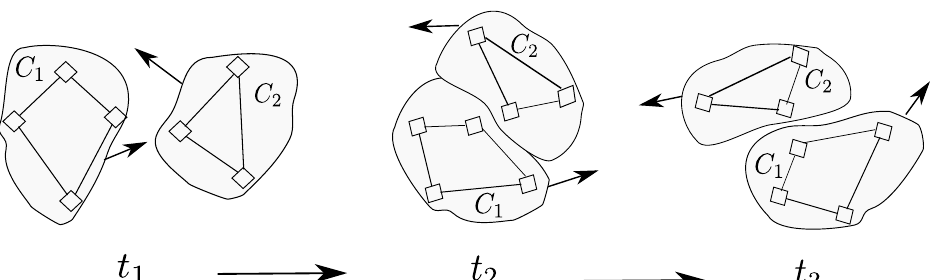
Figure 4: Different time points in cell merge. Arrows from cells indicate direction of cell move- ment.